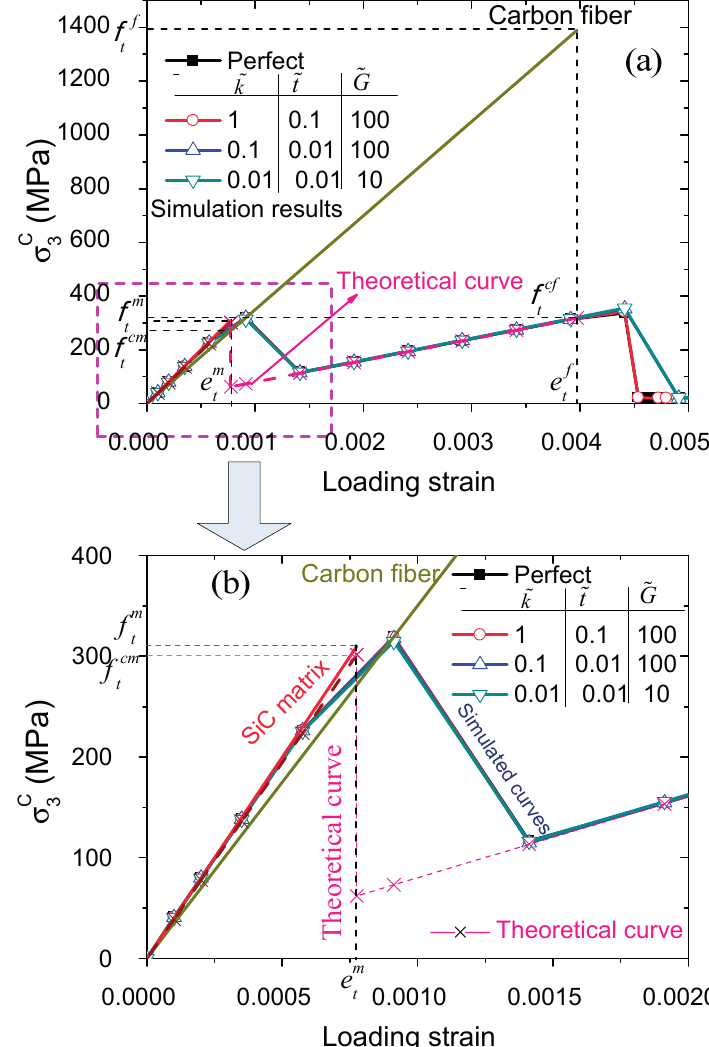
Figure 9. ( a ) Simulated macroscopic stresses in respect to the loading strain for the C/SiC composites with different interfacial properties subject to longitudinal tension along the y 3 direction; and ( b ) the enlarged view in the range of loading strain 0.0 to